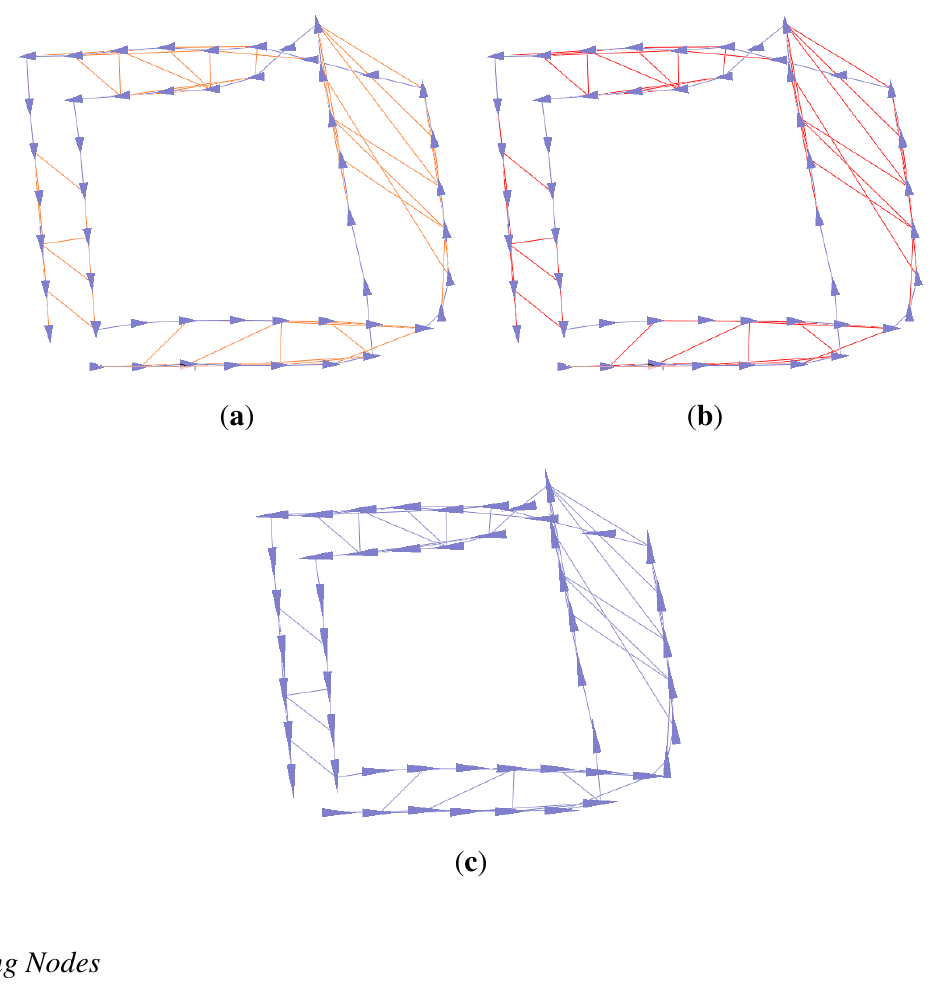
Figure 9. Results of applying different SLAM algorithms for a low dynamic environment. ( a ) Max-mixture algorithm [13]; ( b ) Vertigo algorithm [14]; ( c ) Dynamic covariance scaling (DCS)-based algorithm